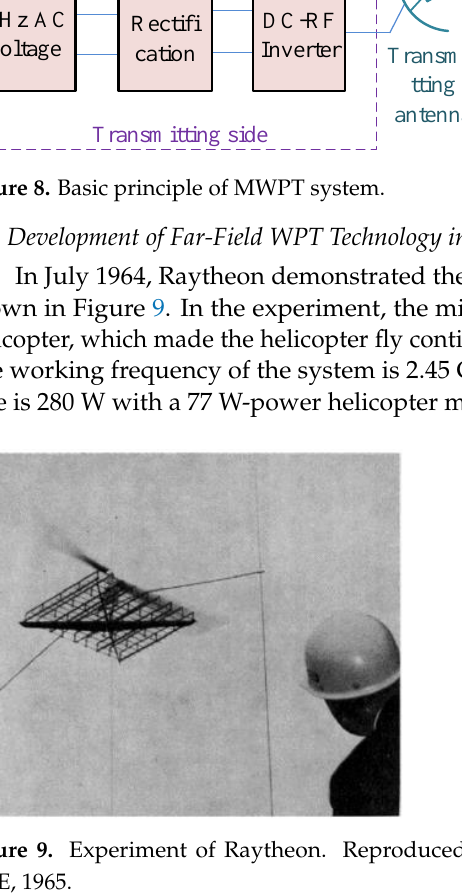
Figure 10. UAV designed by SHARP program. Reproduced with permission from Ref. [39]; pub- lished by IEEE, 1988. In 1992, Japan developed the MILAX (Microwave Lifted Airplane Experiment) pro- gram, which uses microwaves to transfer wireless power for UAVs. In the experiment, the working frequency of the system is 2.411 GHz, and the transmitted power is 1 kW. The microwave is kept on the aircraft through the phased array. The aircraft is a light wooden aircraft with a wingspan of 2.5 m and a weight of 4 kg, and the flight altitude is 25 m [40]. In the 21st century, MWPT technology continues to be developed, but the report of its application in the aviation field is limited, while widely used in other fields. Among them, Japan, as an island country, pays more attention to the development of MWPT tech- nology due to a shortage of resources [41 – 43]. In 2015, Mitsubishi Heavy Industries of Japan transmitted 10 kW of power energy and lit LED lights beyond 500 m [44]. With the development of WPT technology, the application of LWPT technology in the aviation field has gradually attracted researchers’ attention. In 2003 , NASA first used LWPT to charge for the model UAV in flight, as shown in Figure 11 [45]. In the experiment, a laser with a wavelength of 940 nm and optical power of 500 W was used to provide 6 W power for a UAV model beyond 15 m. The aircraft model flew continuously for 15 min.